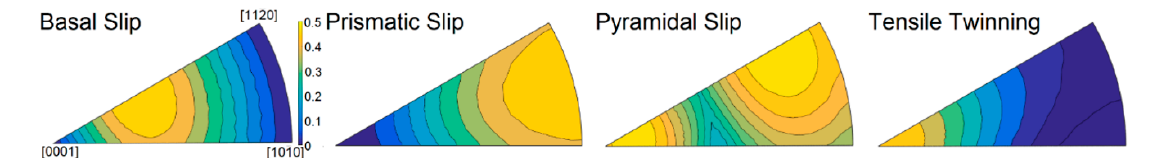
Figure 8. Theoretical calculated Schmid Factors as a function of grain orientation for uniaxial tension, displayed as inverse polfigures.